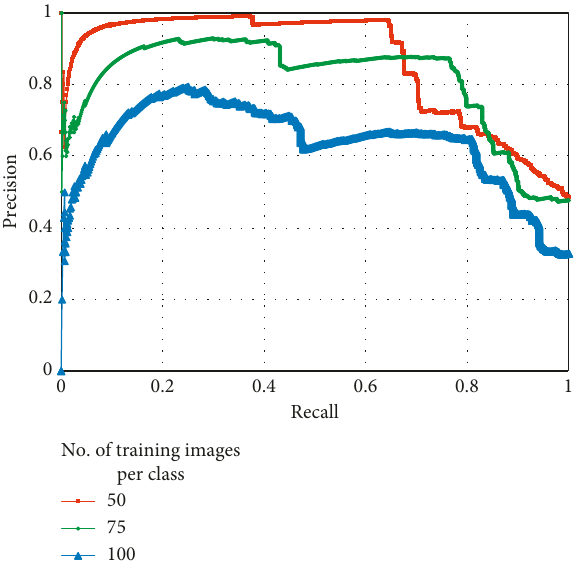
Figure 10: Precision-recall result of iterative model